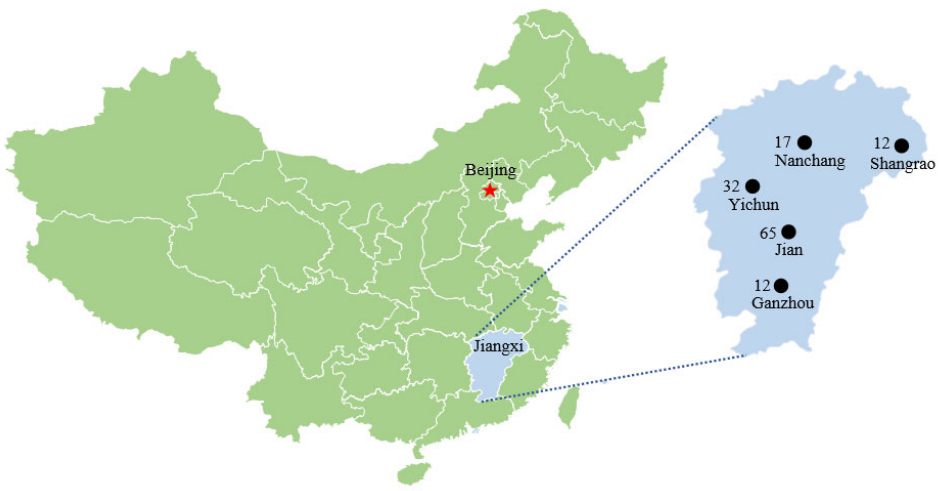
Figure 1. Regions with collected wild boar samples are marked with black dots in Jiangxi province of China. Table 1. Total number of harvesting wild boar samples in Jiangxi province.